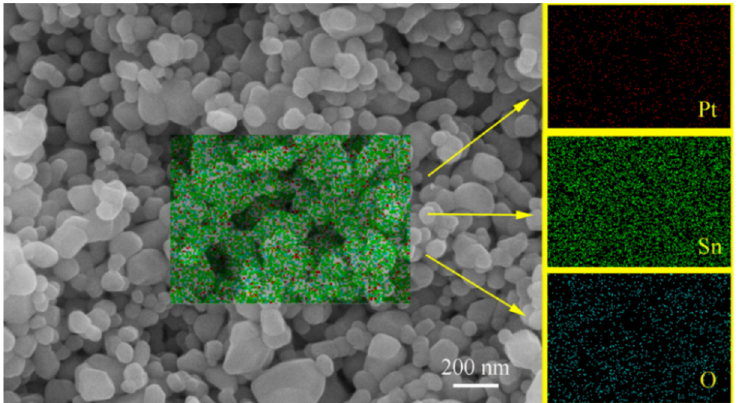
Figure 4. SEM micrograph with EDS analyses for a sample of 1.00 wt% Pt sintered at 1200 °C for 2 h in air.